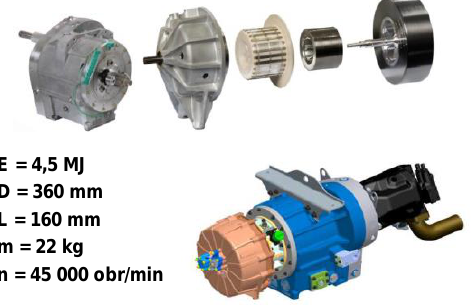
Fig. 11. The flywheel and its components with 220 kJ TorqStor from Ricardo [6]